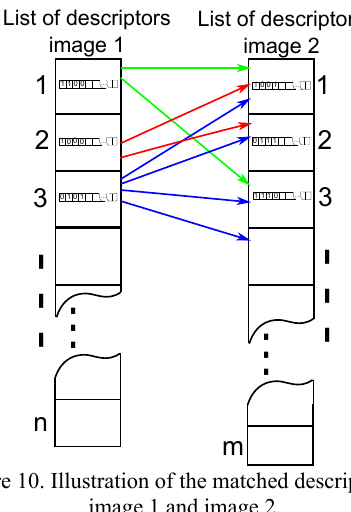
Figure 10. Illustration of the matched descriptors of image 1 and image 2.